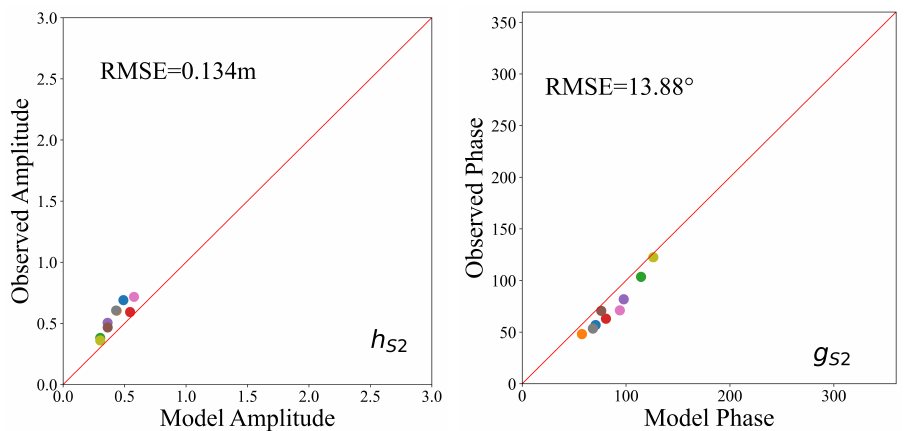
Figure 5. Regression analysis of the amplitude, h , and phase, g , for the M 2 and S 2 harmonic constituents. We also used the measured data obtained from two ADCPs to verify the agreement in terms of tidal current velocity, and the locations of the two ADCPs are labeled in Figure 4b. The simulation from ADCP2 was in great agreement with the observed data, both in the longitudinal and latitudinal components. We selected 10 days of data and present the results in Figure 6. In contrast, the data deviation at ADCP1 was more pronounced, with a certain degree of difference in both amplitude and phase. Because of the longer duration of continuous data at ADCP1 and the necessity of tidal deviation revision, the observation from ADCP1 was elected for the subsequent research.